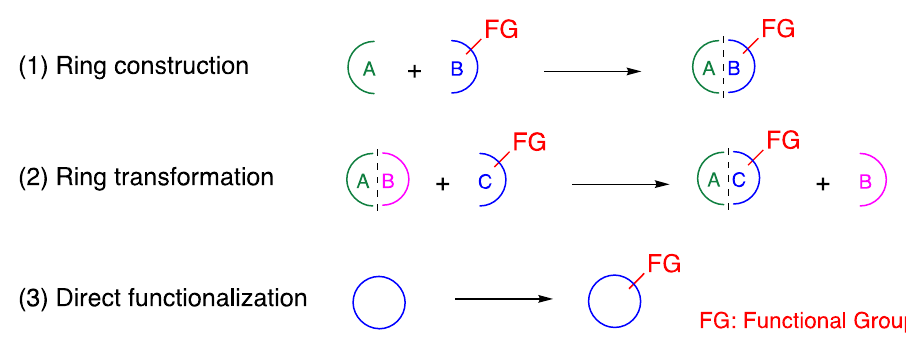
Figure 2. Conventional strategies for the functionalization of aza-heterocycles.